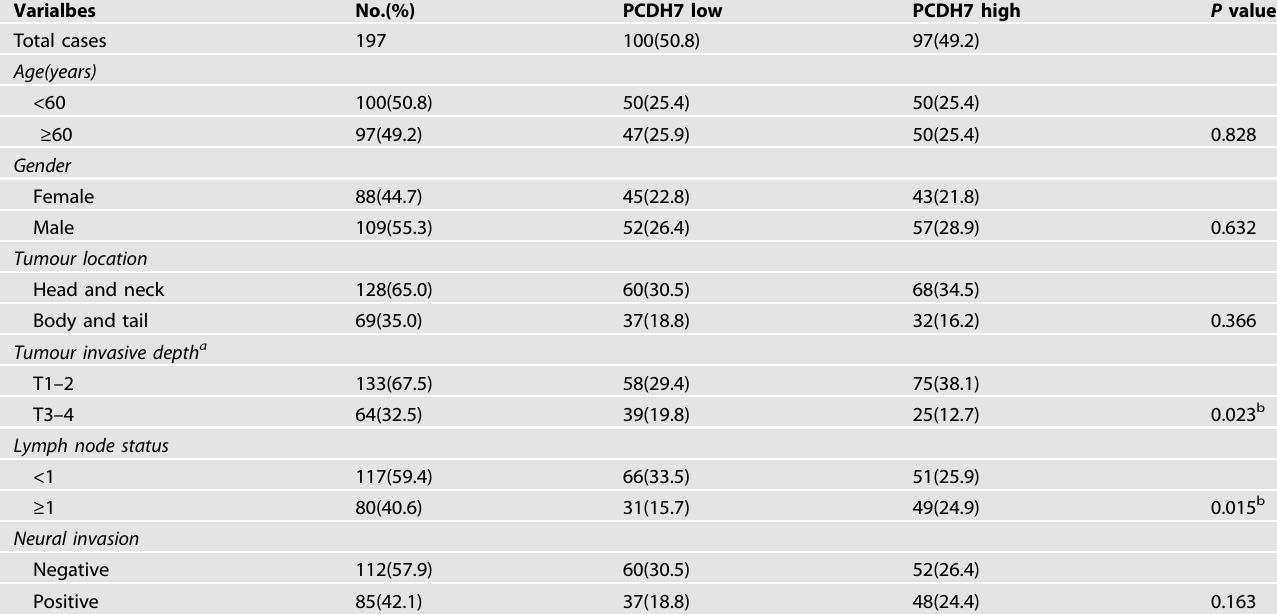
Table 1. Clinicopathological fi ndings and correlation with PCDH1